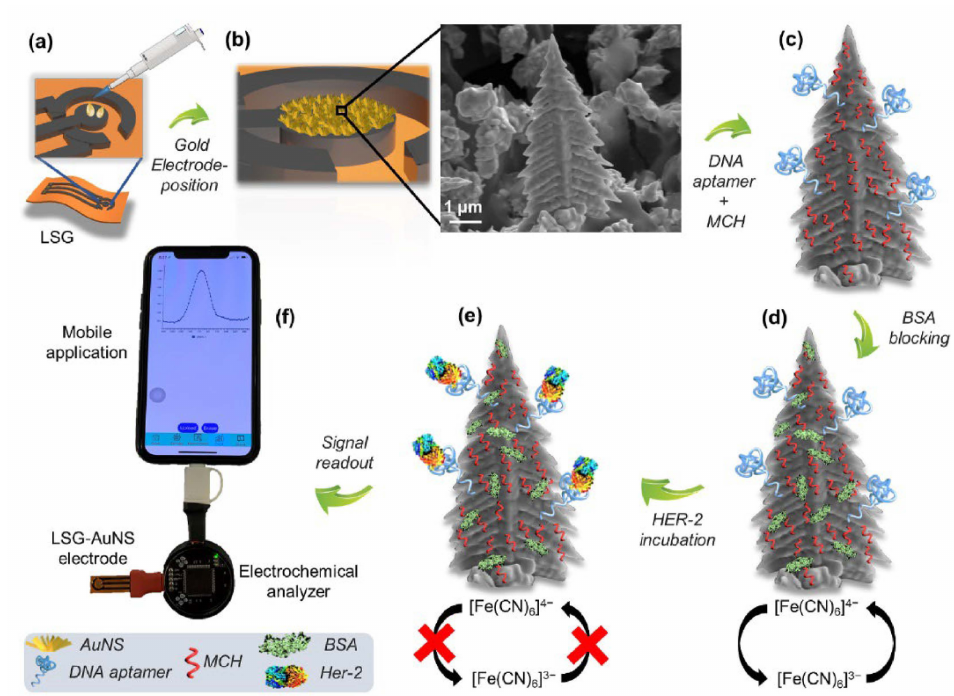
Figure 19. Schematic presentation of laser-scribed graphene-based (LSG) biosensor. ( a , b ) The modifi- cation of LSG electrode with AuNS by electrodeposition (Inset: formation of spiky and Christmas tree-like gold nanostructures). ( c ) Modification of biomolecule (DNA aptamer) onto the electrode by self-assembly using mercaptohexanol (MCH). ( d ) Surface blocking with BSA. ( e ) Incubation with the HER-2 antigen. ( f ) Measurement of the electrochemical signal caused by [Fe(CN) 6 ] 3 /[Fe(CN) 6 ] 4 − redox probe. Reprinted with permission from Ref. [124]. Copyright 2021, Elsevier.